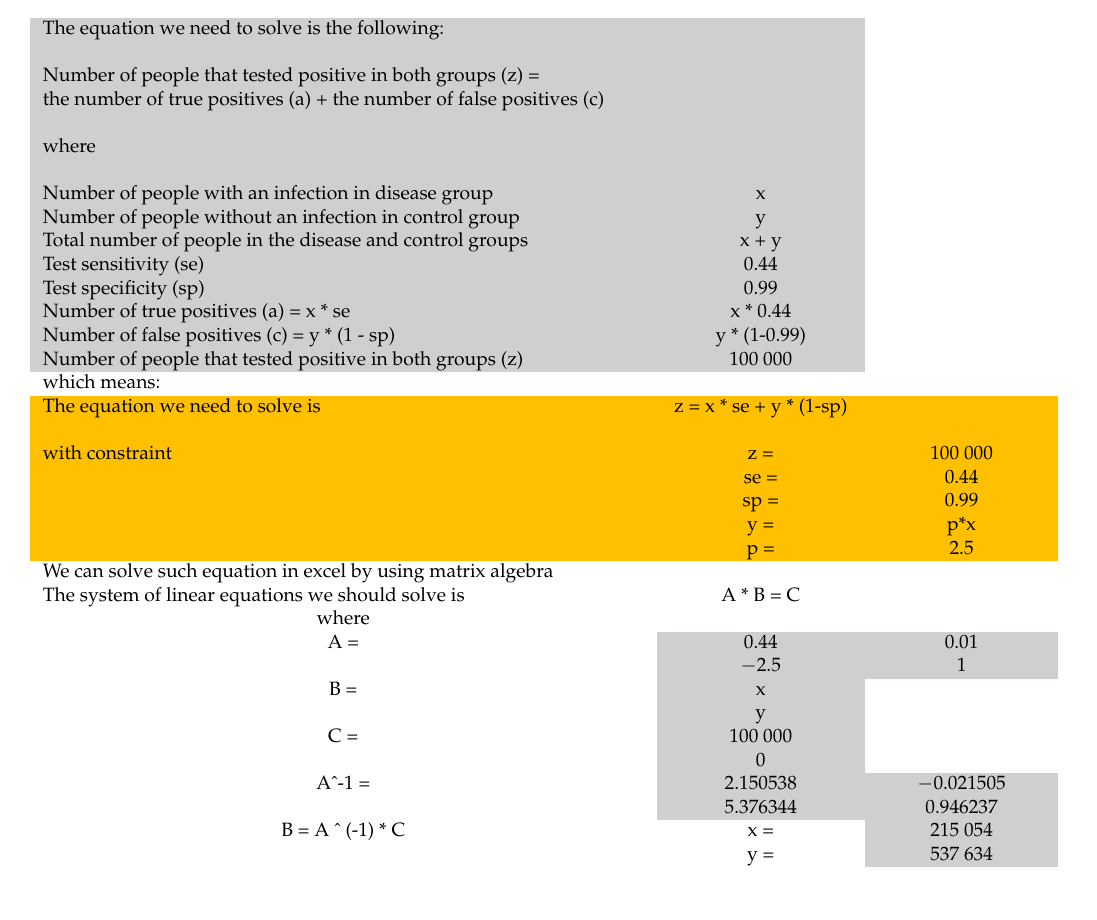
Table 2. How to find x and y with matrix